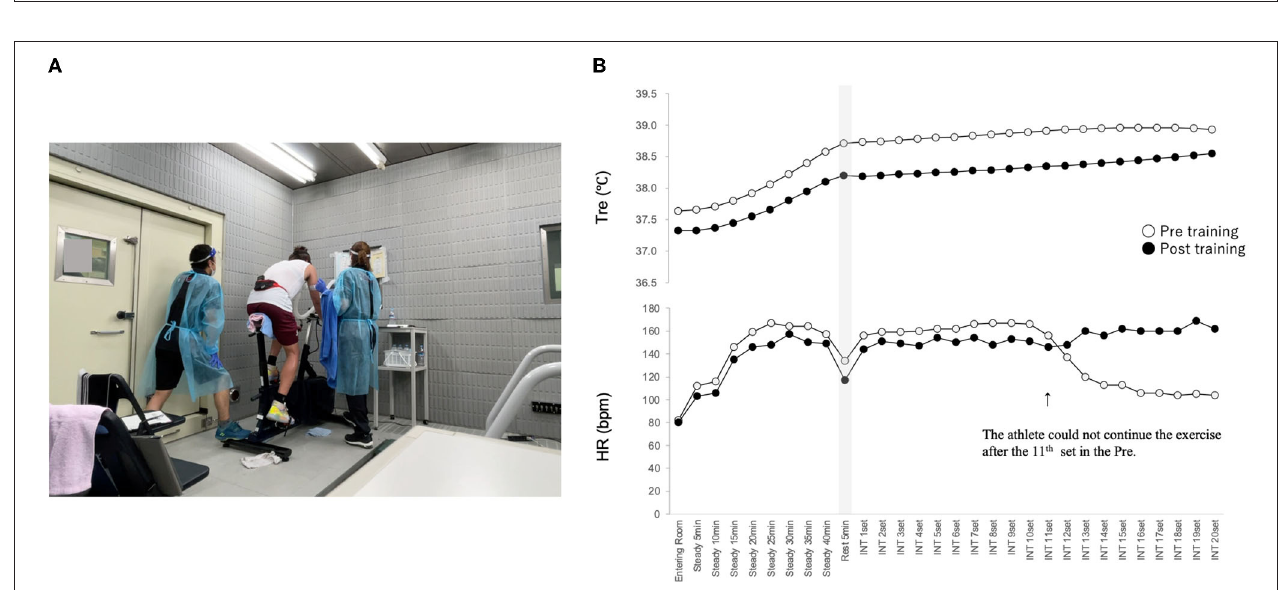
FIGURE 2 | Heat acclimation training. (A) Heat acclimation training considering infection control. (B) Effects of heat acclimation training [typical core body temperature and heart rate